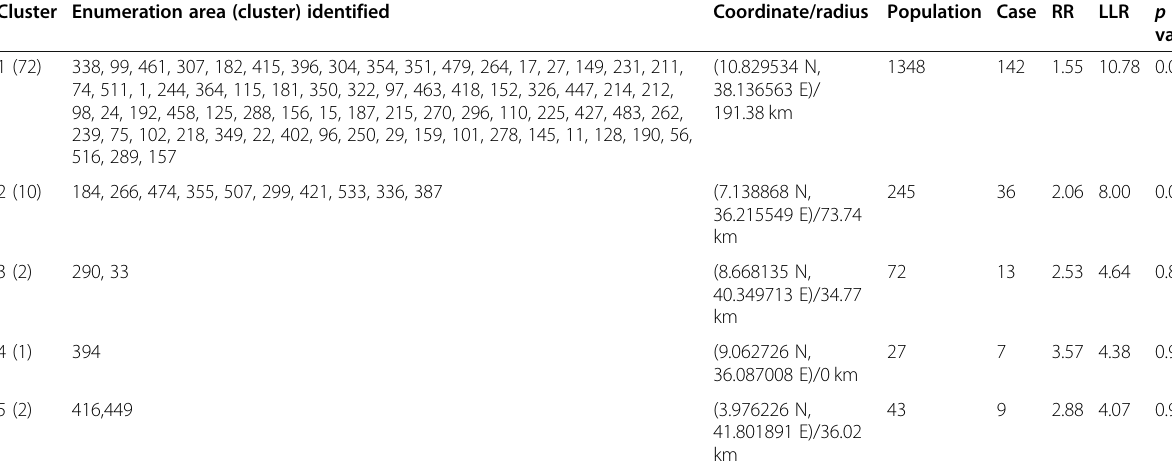
Table 3 Spatial scan statistical analysis of hotspot areas of infant mortality in Ethiopia, 2005 Cluster Enumeration area (cluster) identified Coordinate/radius Population Case RR LLR